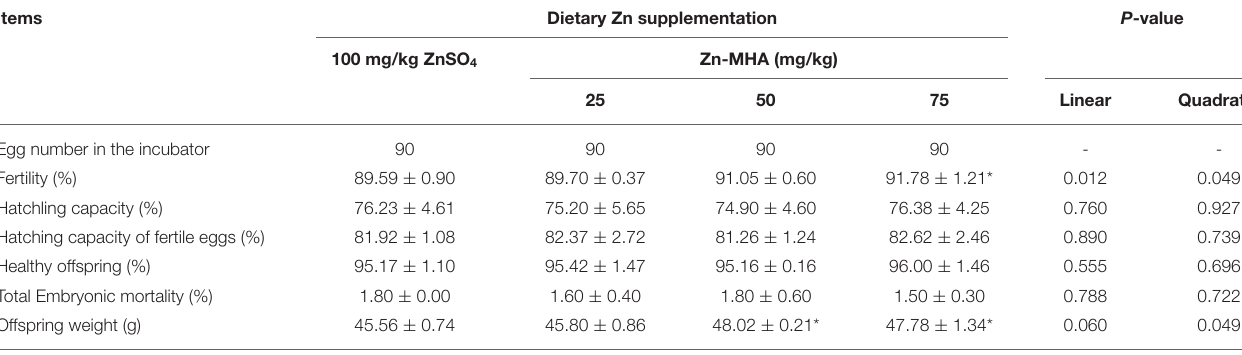
TABLE 5 | Effects of dietary Zn-MHA supplementation on hatching performance in broiler breeders a . Items